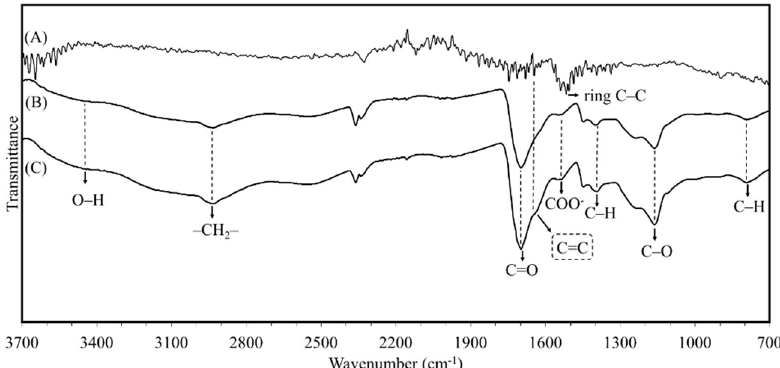
Figure 2. The infrared spectrum of ( A ) B-MWCNTs, ( B ) PA-co-IA / NaOH hydrogel, and ( C ) bamboo-like multiwall carbon nanotubes (PAA-co-IA / NaOH / B-MWCNTs).